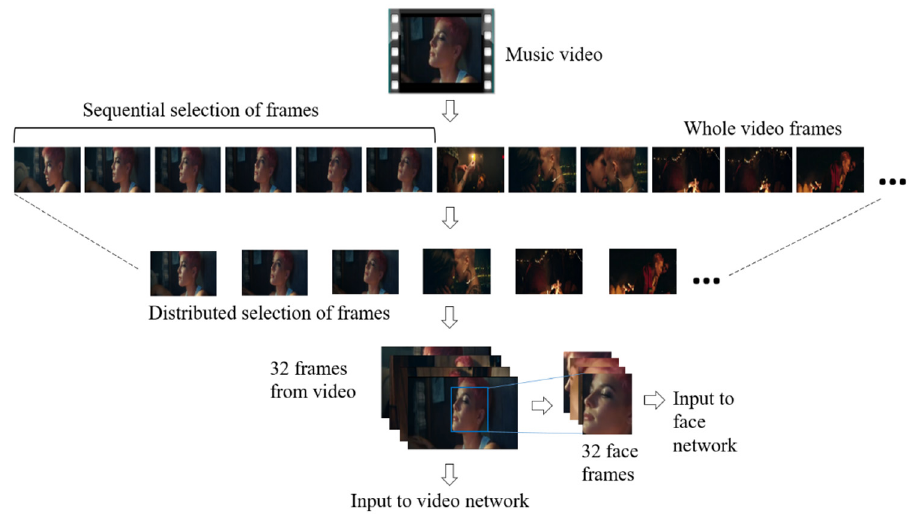
Figure 1. Input video processing by using the distributed selection of frames and faces.